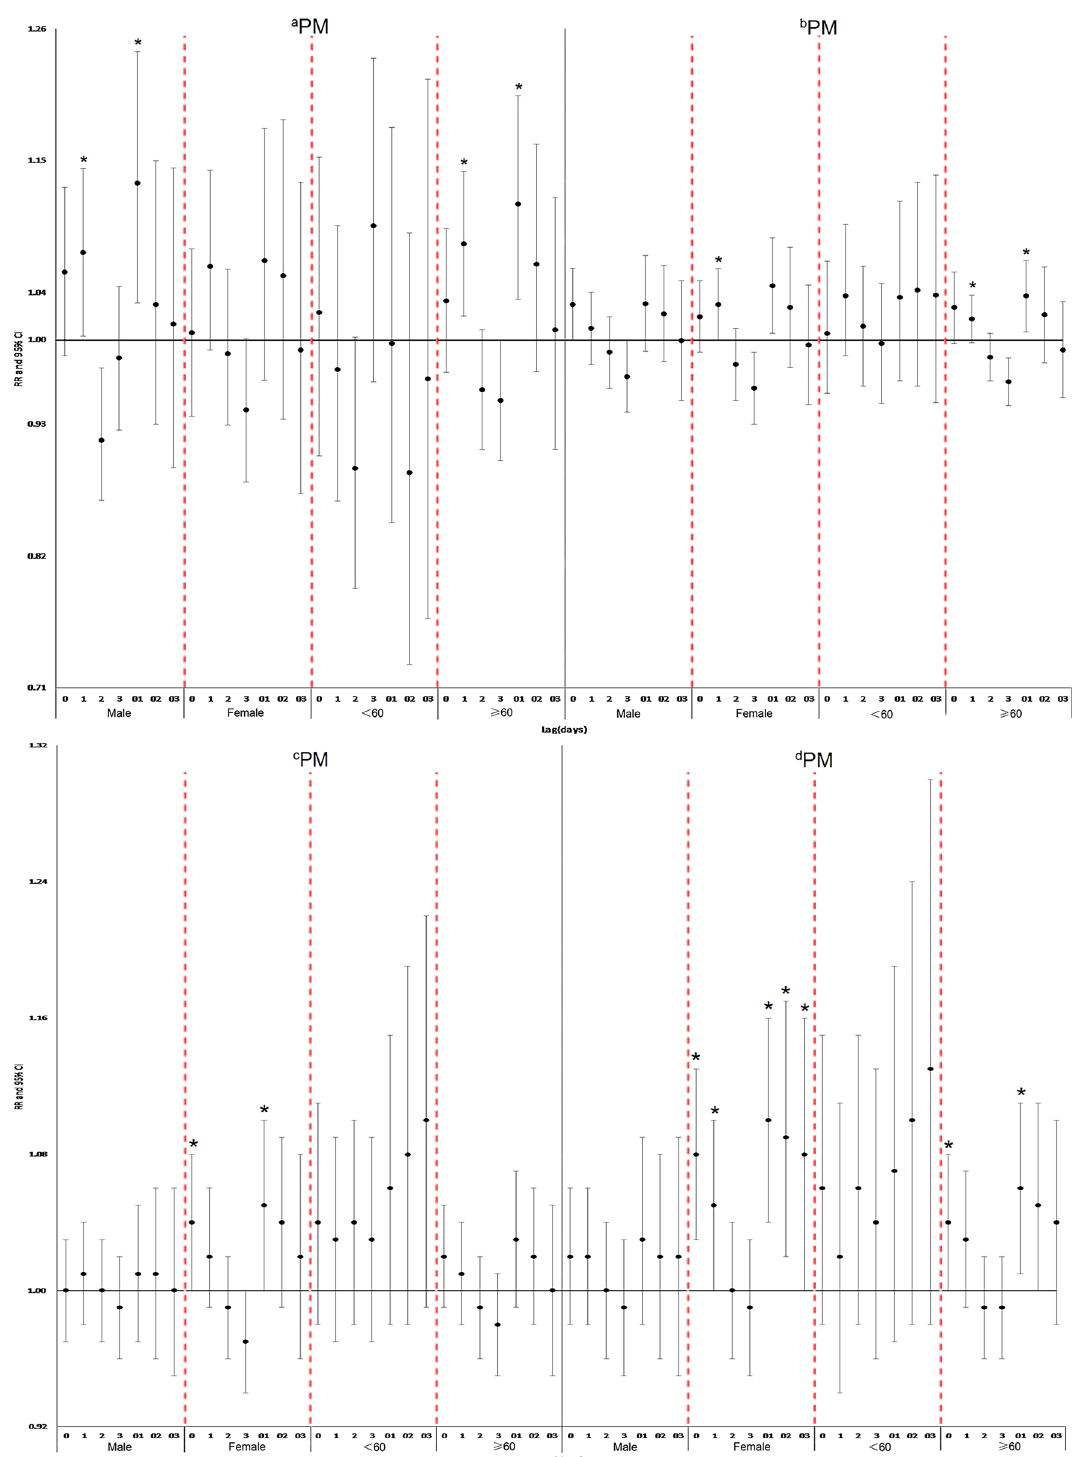
Figure 2. Lag structures of age and gender-specific relative risk (RR) of daily mortality from exposure to different